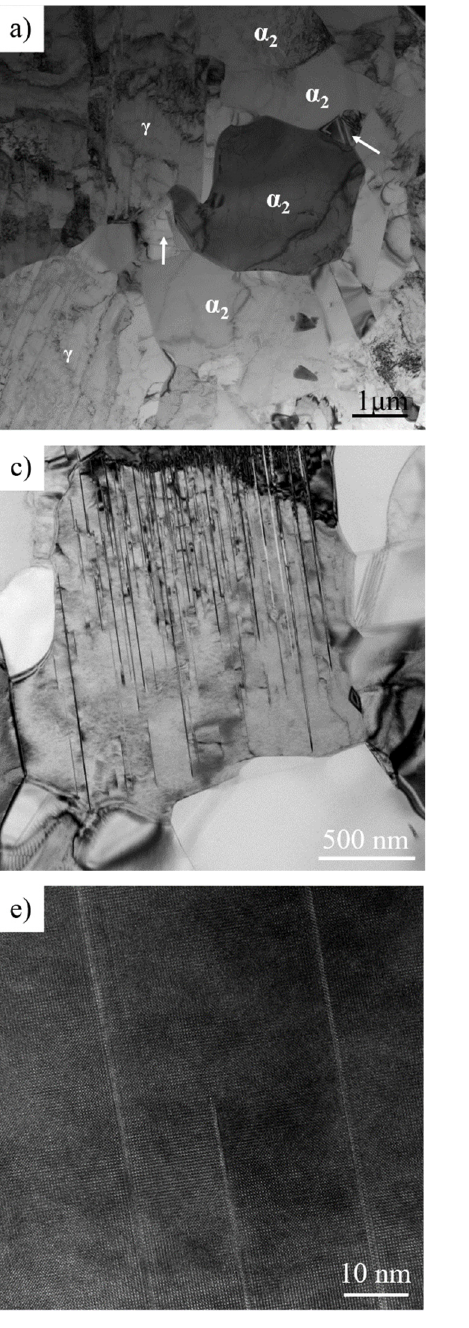
Figure 9. TEM analysis of the microstructure around the lamellar colony in as-quenched Ti-44Al- 8Nb-(W, B, Y) alloy after three rolling passes. ( a ) The γ grains distributed at recrystallized α grains; ( b ) the diffraction pattern of γ grain; ( c ) the γ lamellae precipitated from α grains; ( d ) the diffraction pattern of α grain; ( e ) High resolution TEM images of the γ lamellae in α grain and ( f ) recrystallized α and γ grains around a lamellar colony.